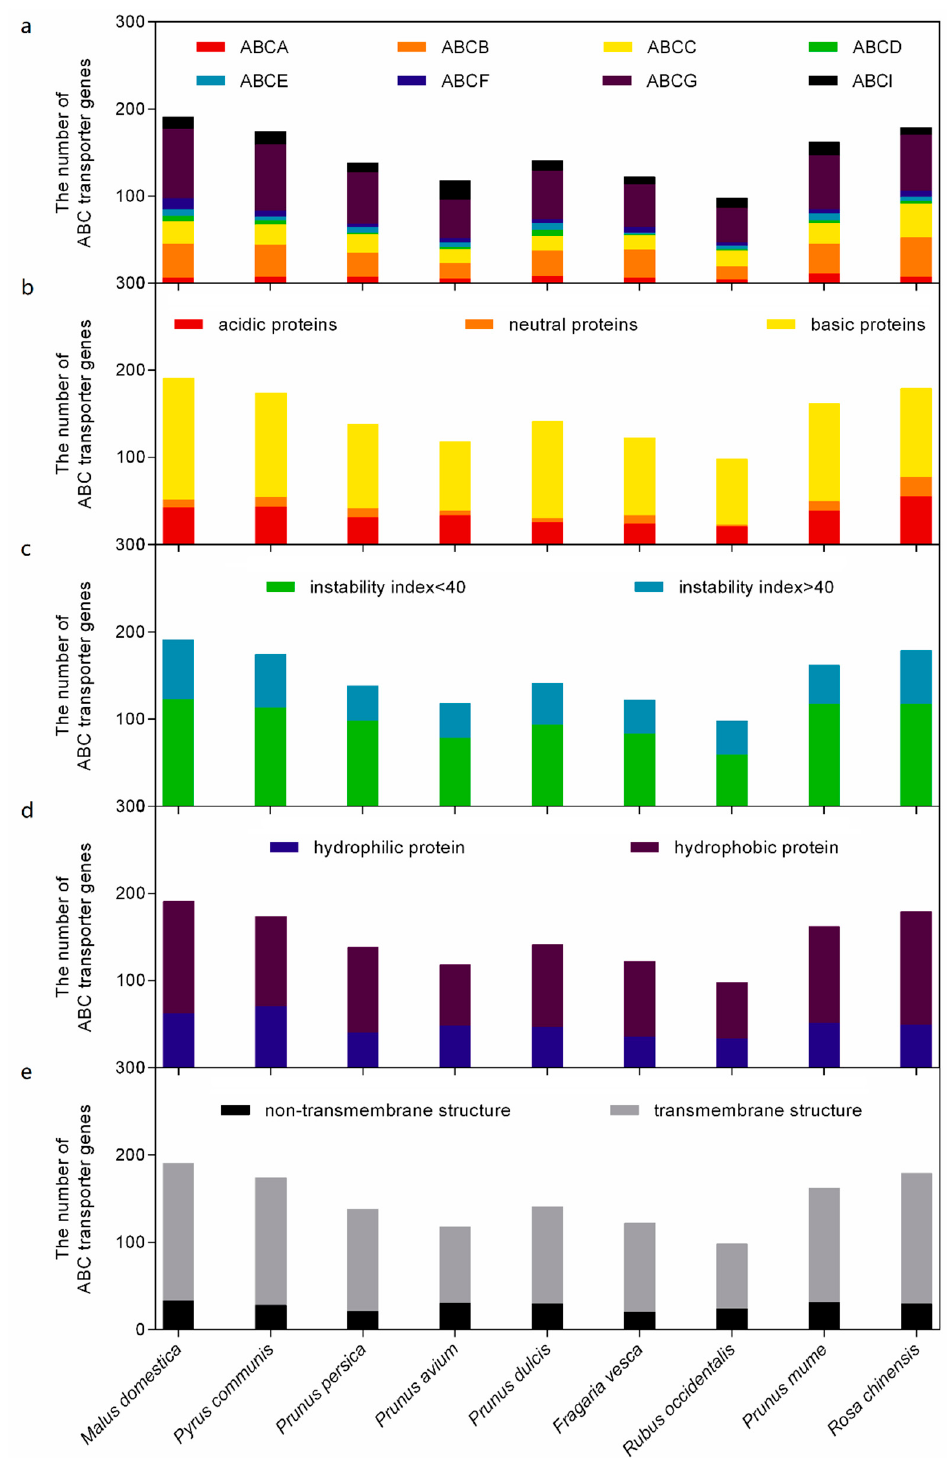
Figure 1. Numbers of ATP-binding cassette (ABC) transporter family members for each classification in Rosaceae: ( a ) subfamily; ( b ) isoelectric point; ( c ) instability index; ( d ) grand average of hydropathicity; ( e ) transmembrane structure.